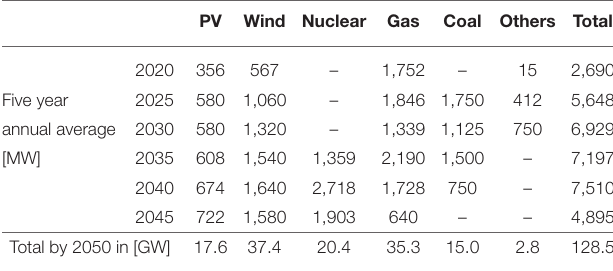
PV Wind Nuclear Gas Coal Others